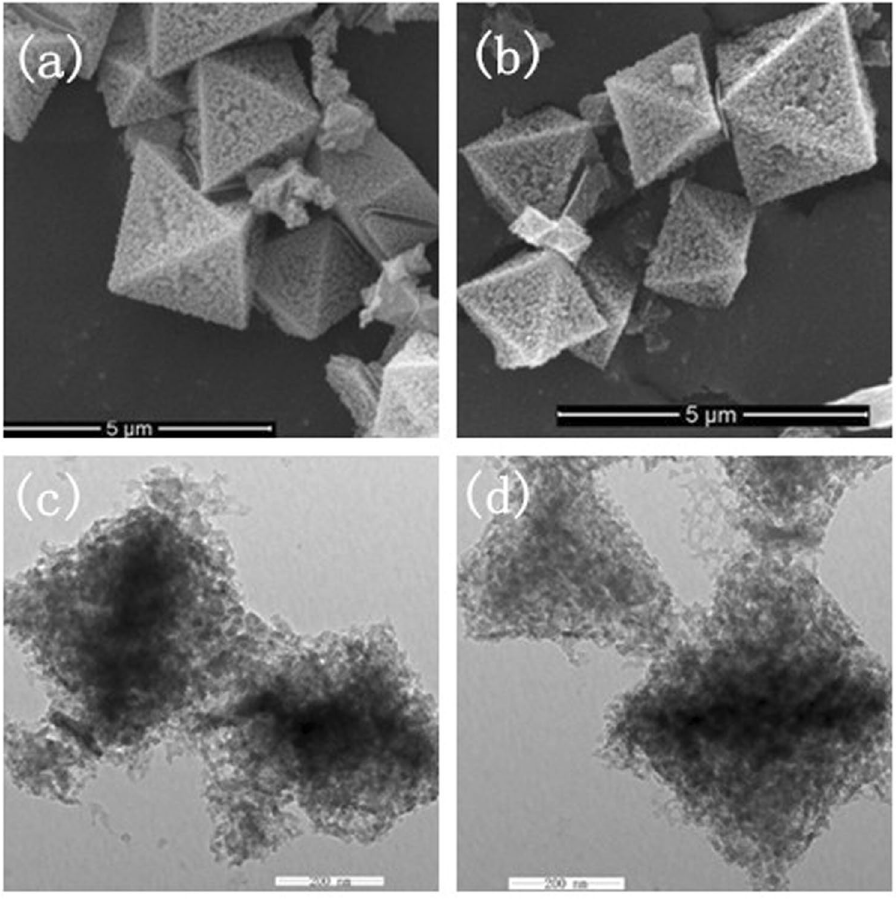
Figure 5. SEM images of ( a )MIL-101, (b)NH 2 -MIL-101 and TEM images of ( c )MIL-101(Fe), ( d ) NH 2 -MIL-